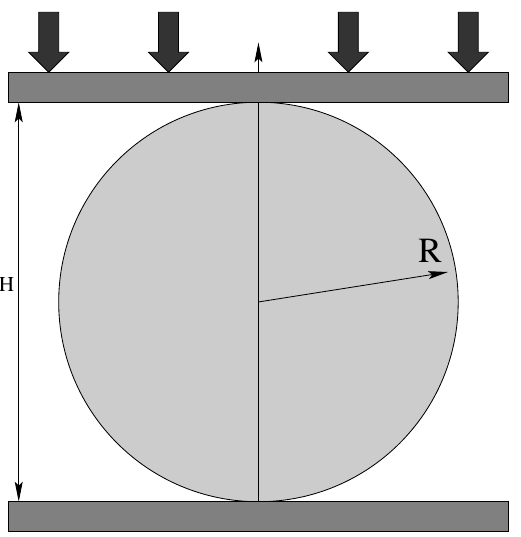
Figure 1. Spheroid compression